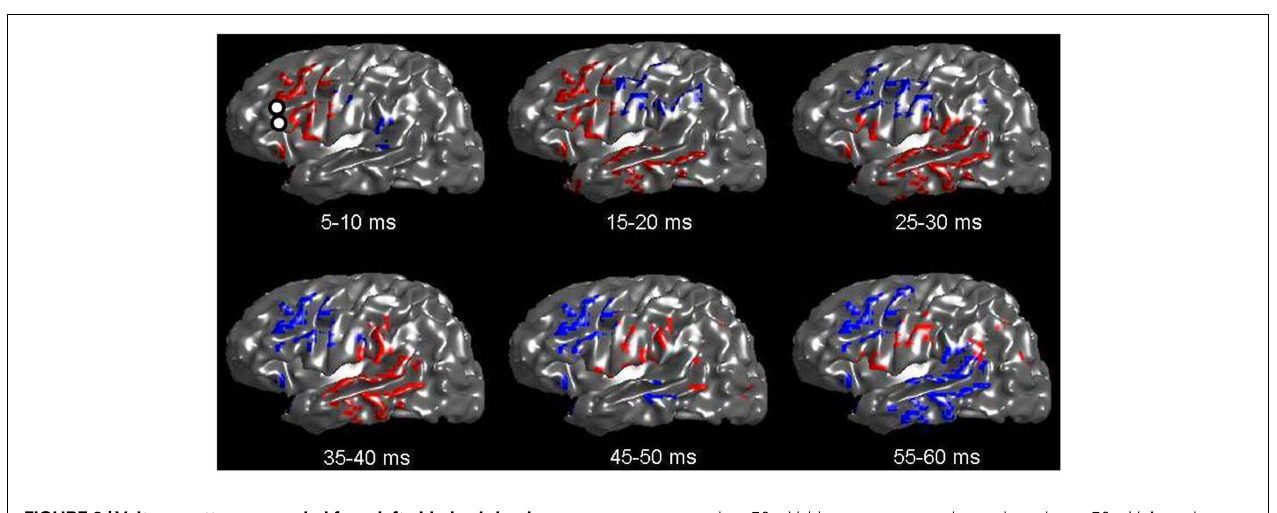
FIGURE 2 |Voltage patterns recorded from left-sided subdural grids in response to a CCEP stimulation at left Broca’s region (whose electrode-pair is shown as two white circles in the first image) .The underlay is the inflated brain.Voltages are taken as the average during a 5ms window. Red represents positive voltages